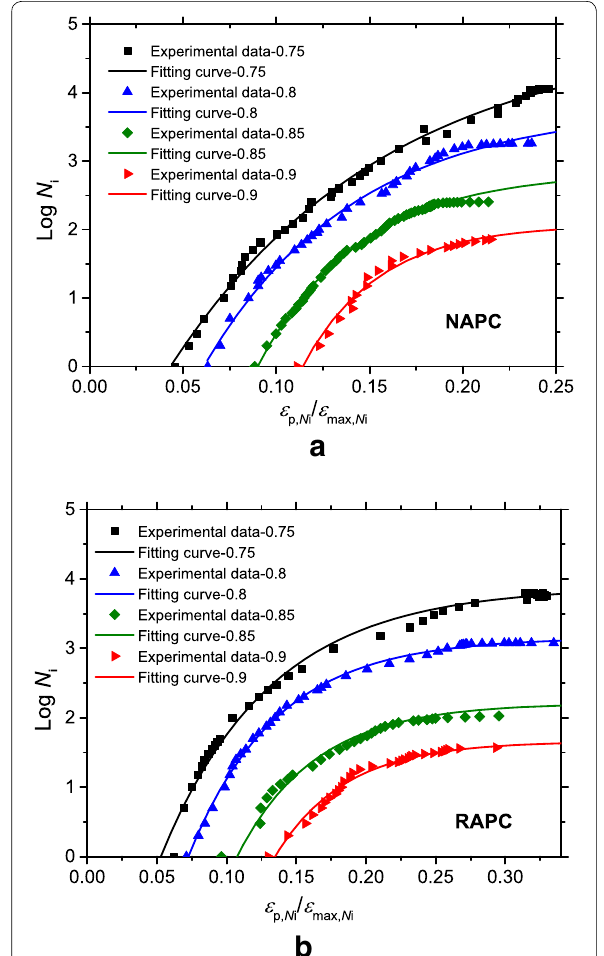
Fig. 13 Fitting curve of fatigue life for pervious concrete: a NAPC and b RAPC.